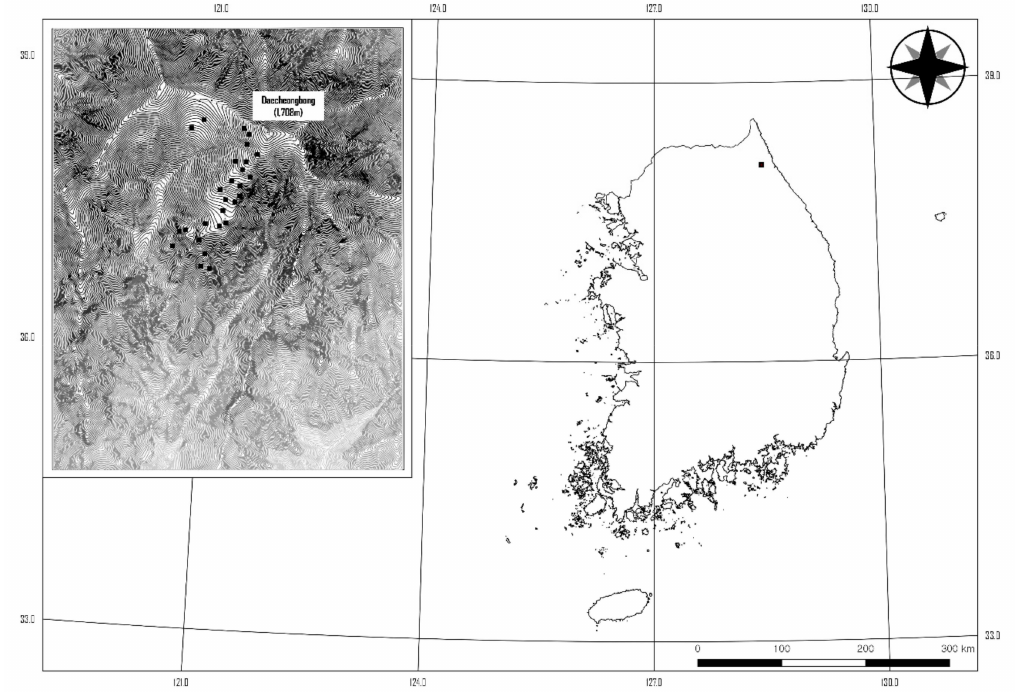
Figure 2. Location and topography of the study quadrats in Seorak Mountain, South